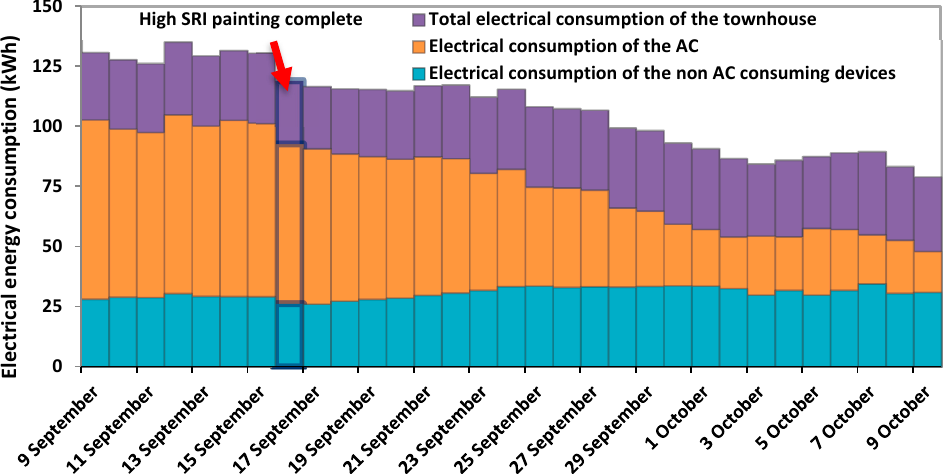
Figure 13. Electrical energy consumption recorded in the townhouse during the test cycle.